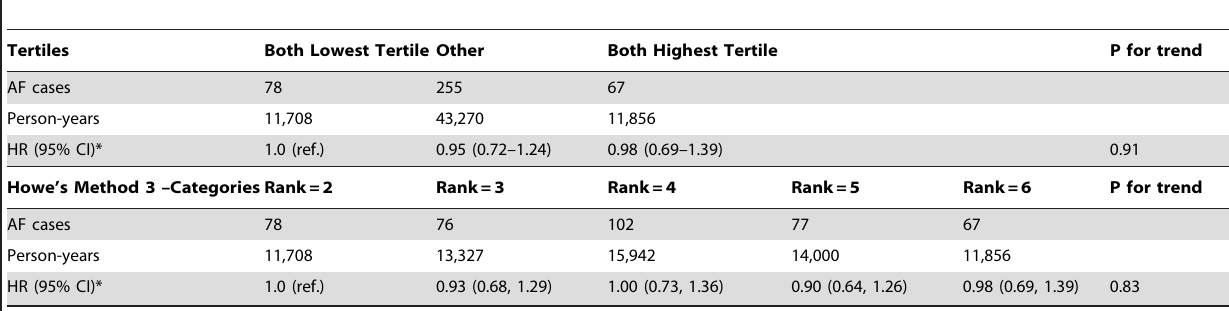
Table 5. Hazard ratio (95% confidence interval) of atrial fibrillation by combined dietary and biomarker DHA and EPA, ARIC Minnesota field center,